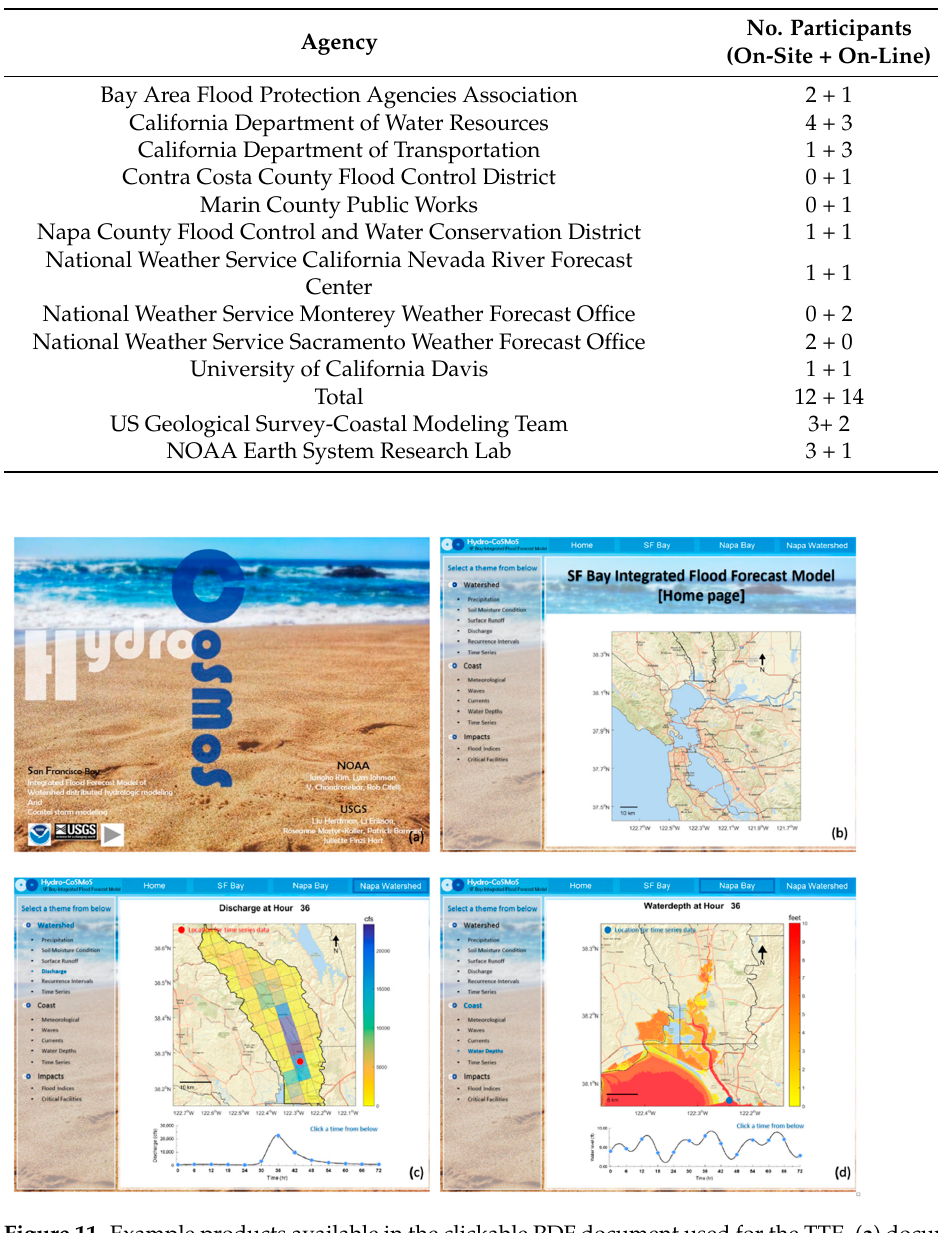
Table 1. Agencies participating in the TTE.